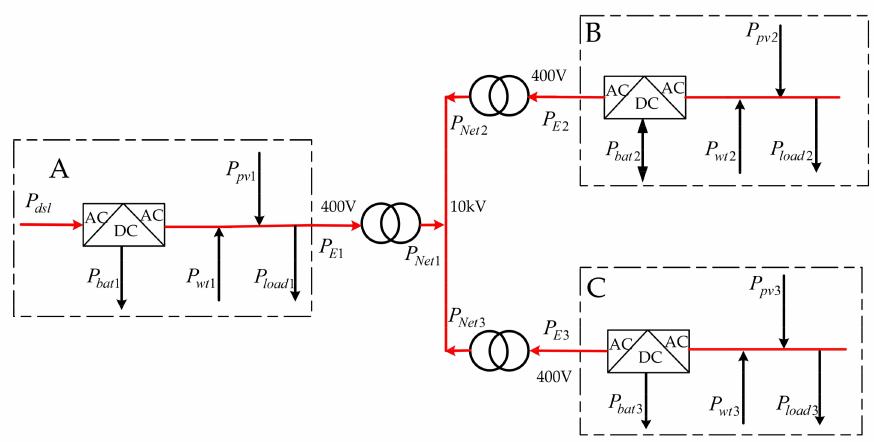
Figure 6. Power flow graph of modular